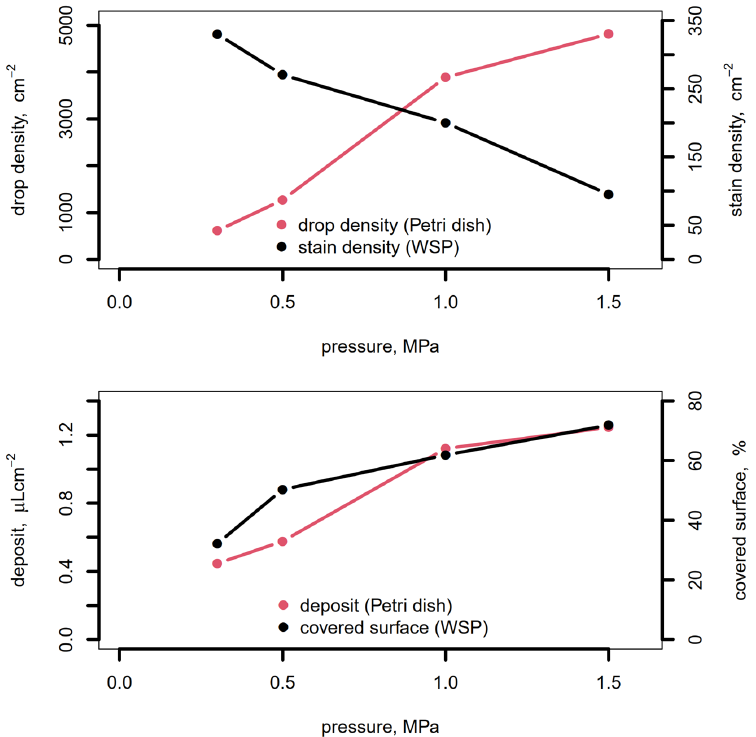
Figure 8. Comparison between Petri dishes and WSPs in terms of drop density, stain density, deposit and covered surface.